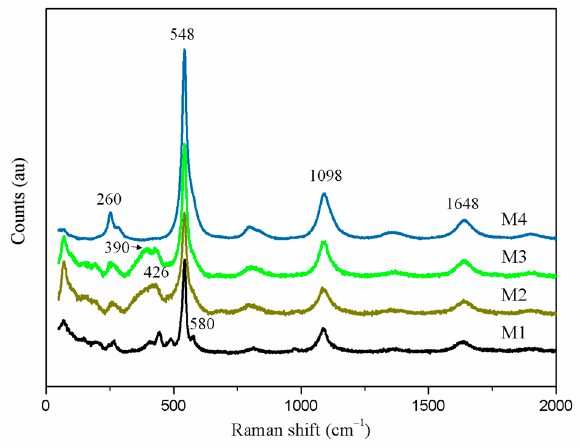
Figure 4. Photographs and colorimetric parameters (L*, a*, b*) of the products.